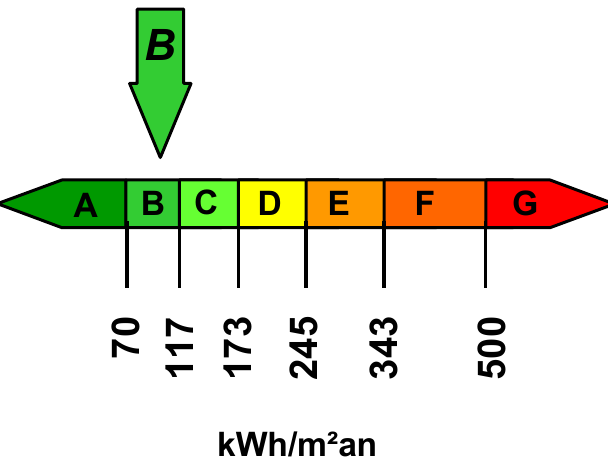
Figure 12. Energy class based on the energy consumption for heating.